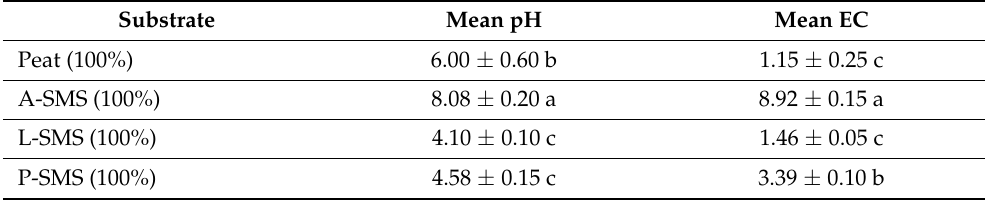
Table 4. The pH and EC (mS · cm − 1 ) values of 100% peat and 100% fresh SMSs used in the study. Substrate Peat